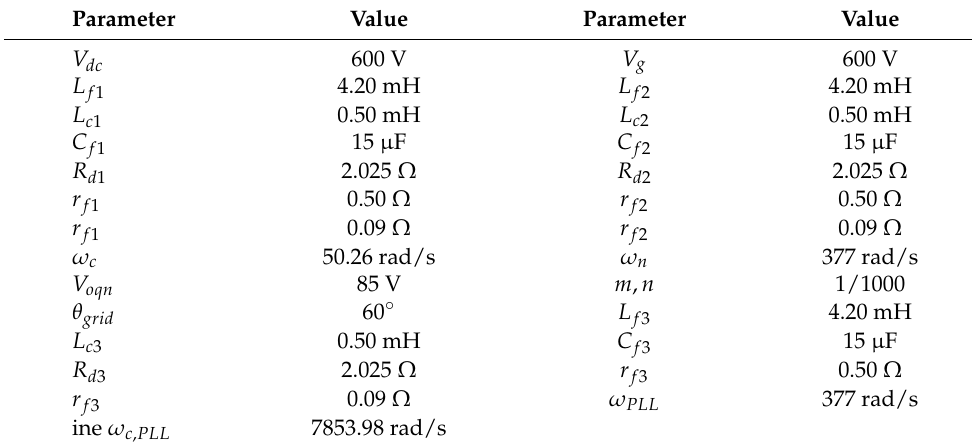
Table 1. Microgrid system parameters.